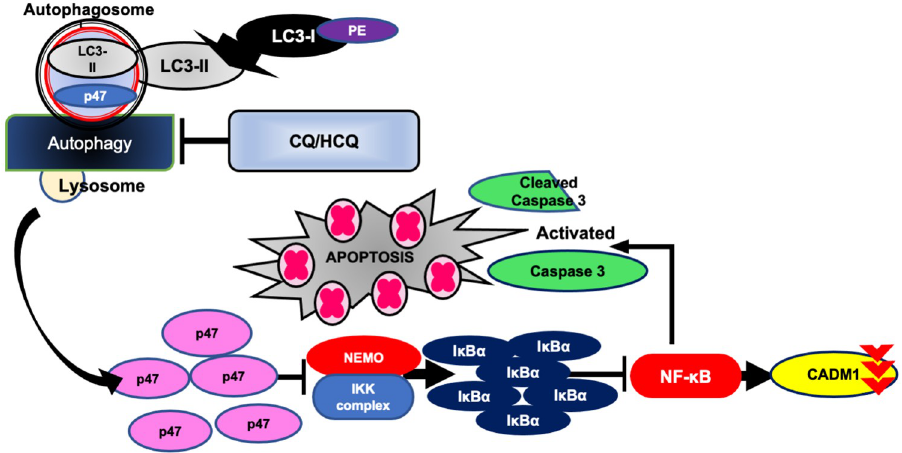
Fig 4. Model illustrating the mechanism of CQ/HCQ-induced ATLL cell apoptosis by autophagy and NF- κ B pathway inhibition. In ATLL cells, p47 is degraded by the autophagy-lysosome pathway, leading to increased NEMO protein level and activation of IKK, which result in the constitutive activation of the NF- κ B pathways. CQ and HCQ inhibit autophagy and increase p47 protein level, which inhibit NF- κ B pathway activation along with loss of CADM1 expression, leading to caspase-3 related